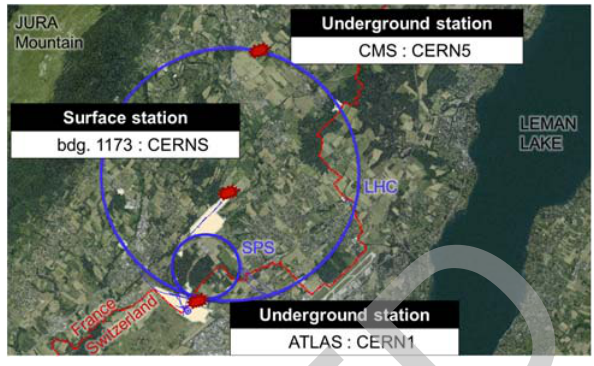
Figure 1: Map of CERN Seismic Network with speci fi ed locations of separate seismic stations [ 11 ] .